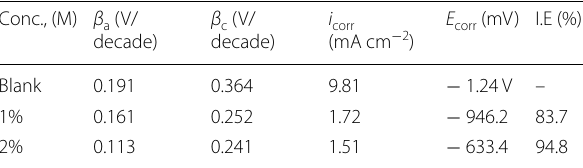
Table 3 Parameters of potentiodynamic polarization results cast iron in 3.5 wt% NaCl in the absence and presence of polyurethane at ambient temperature Conc., (M) β a (V/